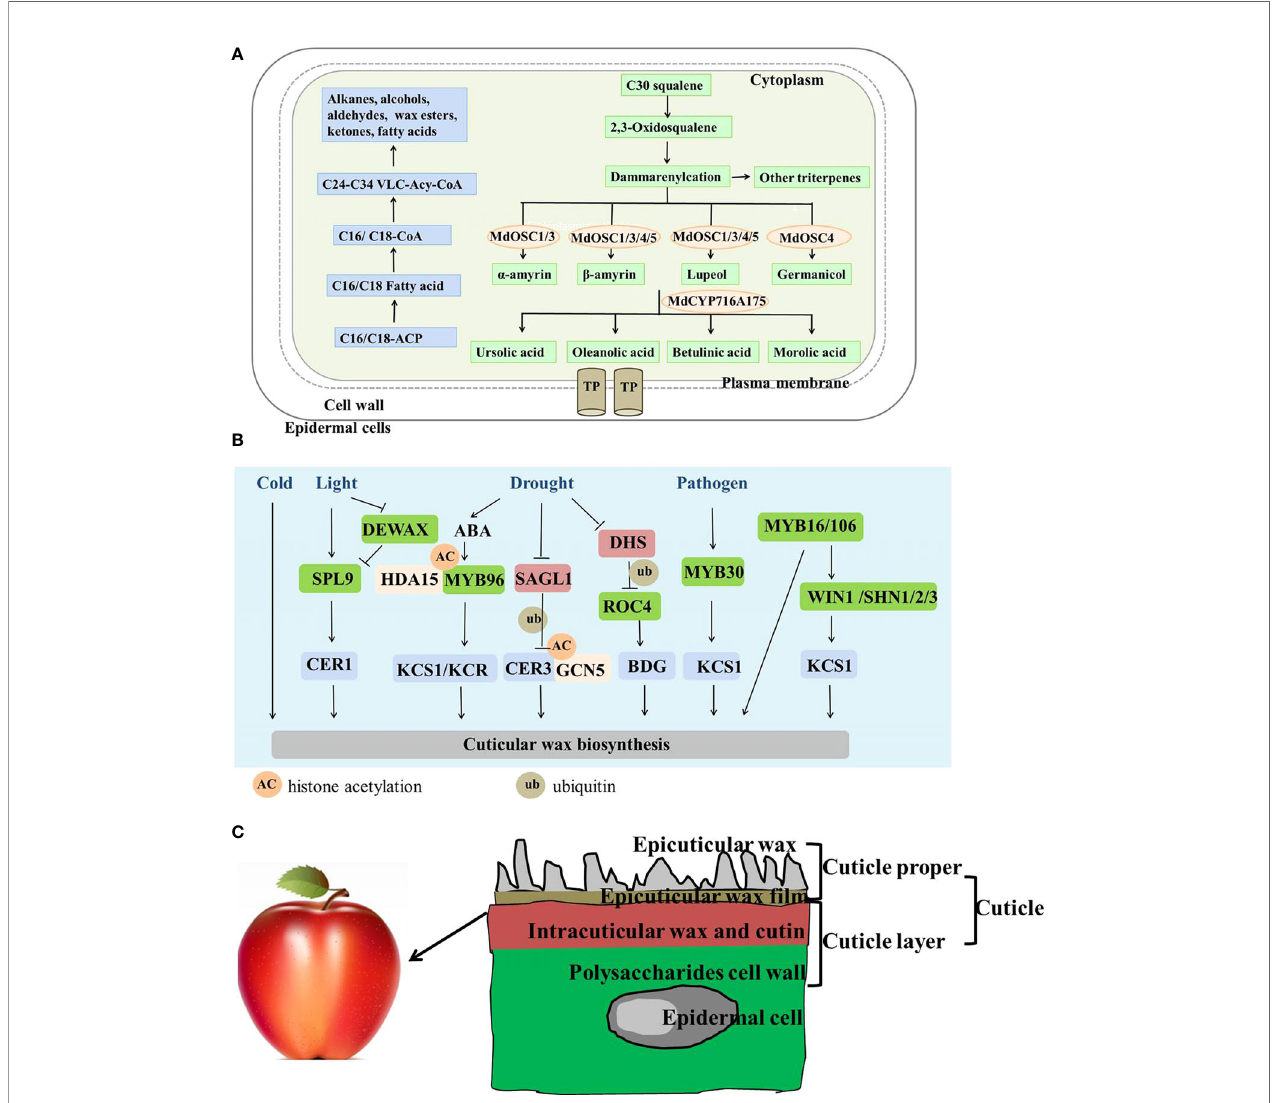
FIGURE 1 | A model of the biosynthesis, regulation, and deposition of apple cuticular wax based on progress made in apple and other plants. (A) Apple cuticular wax biosynthetic pathway. Blue and green represent the same and different synthetic pathways as in Arabidopsis. TP, transport protein. (B) Environmental and genetic co-regulatory networks of cuticular wax biosynthesis at different regulatory levels. Blue represents the structural genes related to cuticular wax synthesis; green represents the transcriptional factors related to cuticular wax synthesis; red represents E3 ubiquitin ligase; orange represents the histone acetylation genes (HDA15 and GCN5). (C) Simple deposition diagram of the apple fruit cuticle. Different colors represent different apple cuticular wax components and positions. The graphics are not drawn according to the true